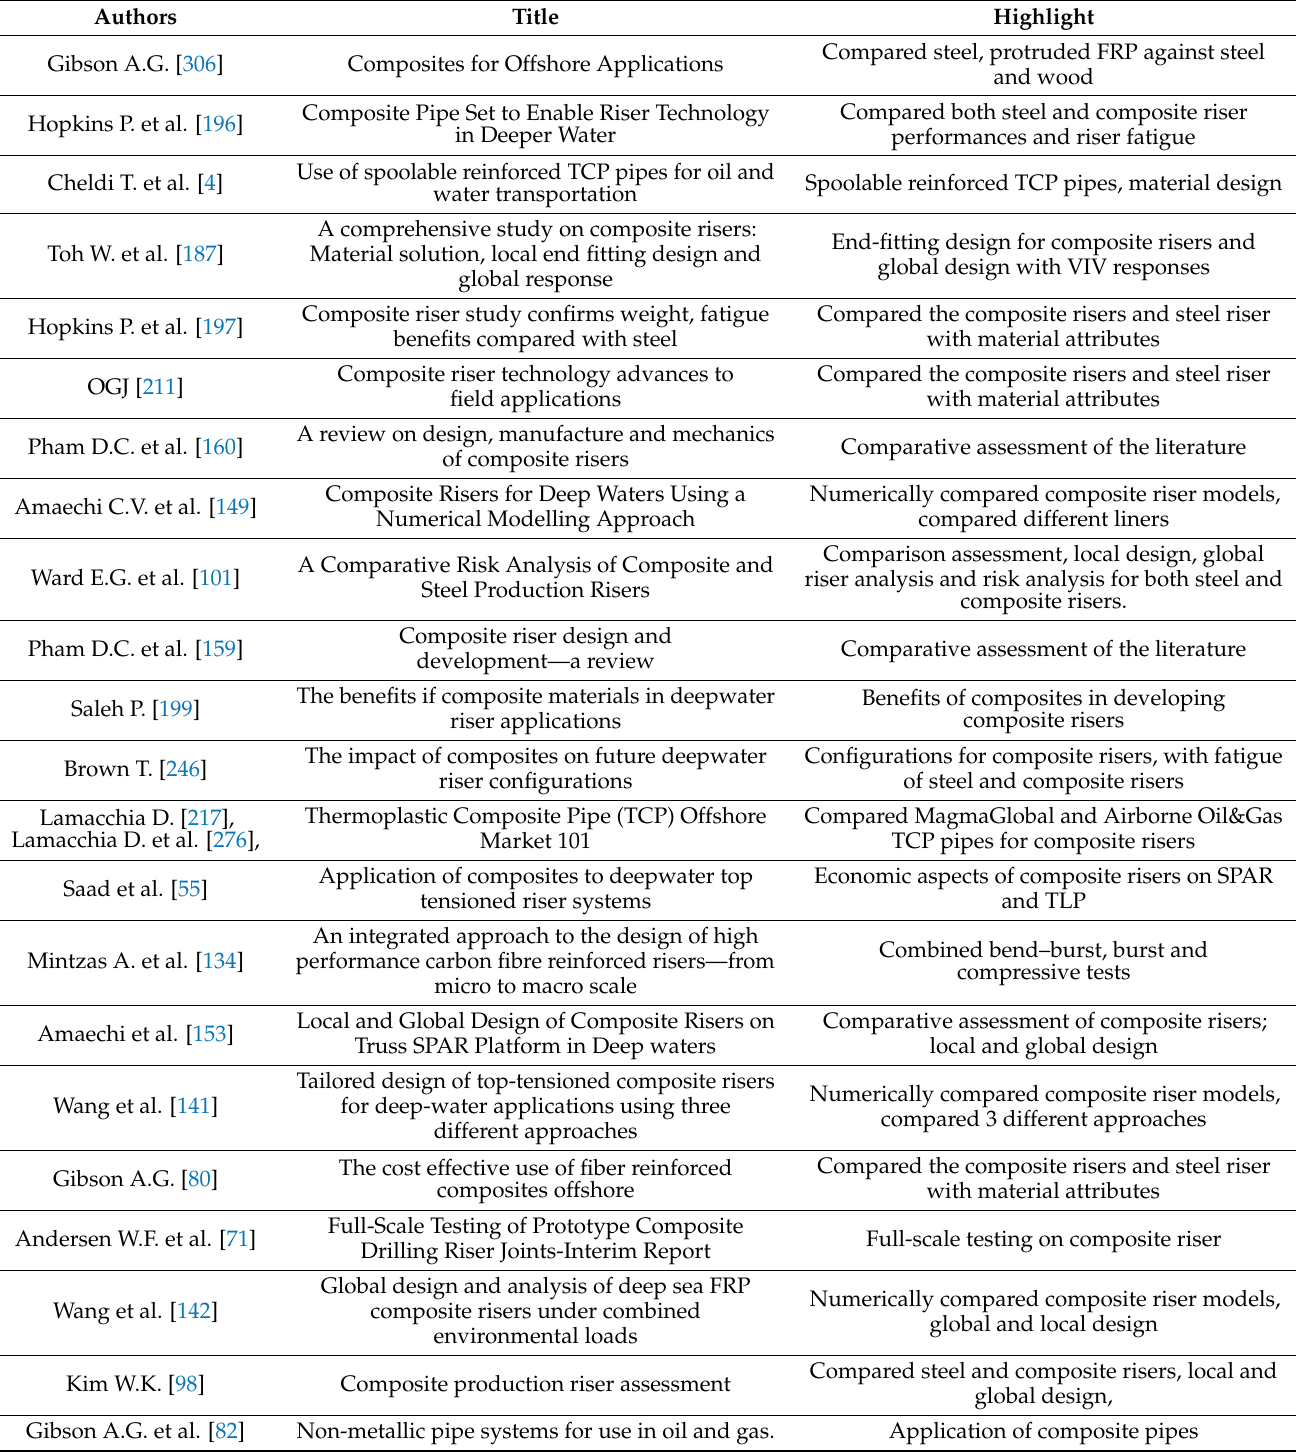
Table 5. Bibliographical list of comparative studies on steel risers and composite